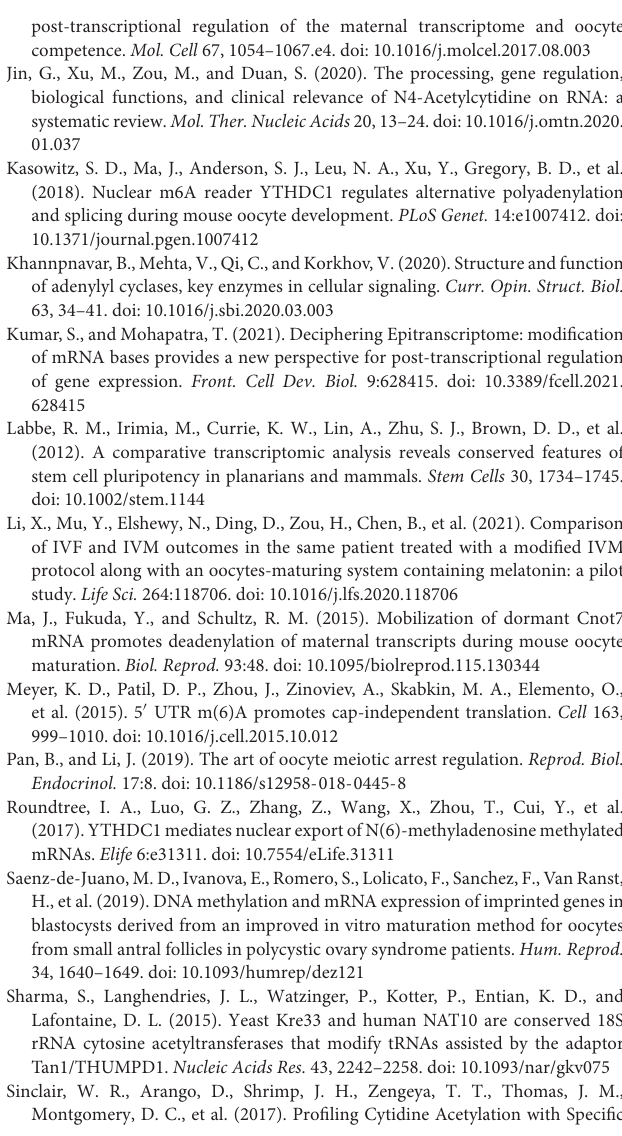
Supplementary Figure 1 | Representative images of negative control staining for immunohistochemistry (without the primary antibody). (A) Negative controls of untreated mouse oocytes. Fluorescence exposure time: GV, 300 ms; MII, 1.9 s. (B) Negative controls of transfected mouse oocytes. Fluorescence exposure